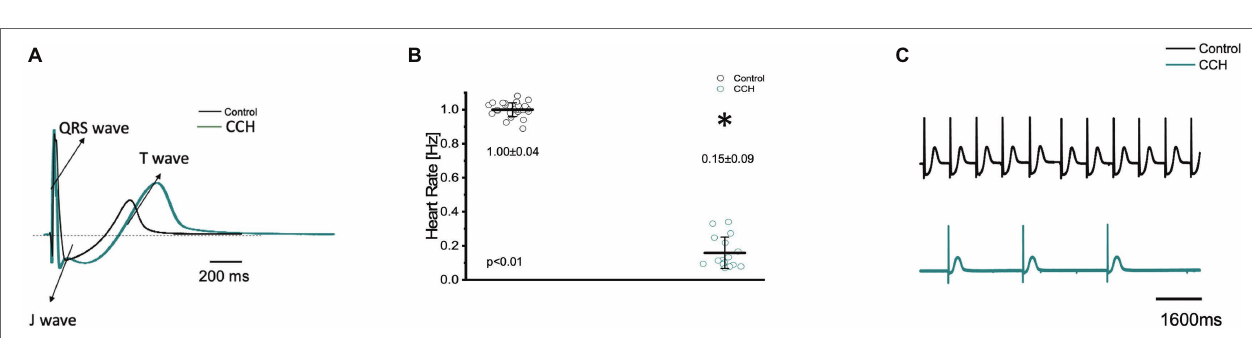
FIGURE 9 | Transmural ventricular electrocardiogram recordings in the absence (black) and presence (green) of 5 μ m carbamylcholine. The three main components of the Goldfish electrocardiogram are presented: QRS complex, J wave, and T wave (A) . Carbamylcholine administration significantly altered the kinetic parameters of all the electrocardiographic signals. Administration of carbamylcholine significantly decreased heart rate from 1.00 ± 0.04 Hz to 0.15 ± 0.09 Hz ( p < 0.01, n = 29 for the control, n = 16 for CCH, N = 6; B ). Electrocardiogram recordings before and after carbamylcholine perfusion reflect a decreased heart rate in response to carbamylcholine (C) . * Denotes a significant difference between the two distributions. The data are presented as multiple measurements ( n ; dot cloud) recorded for different measurements ( n ) on different hearts ( N ) with the mean ± SEM (solid